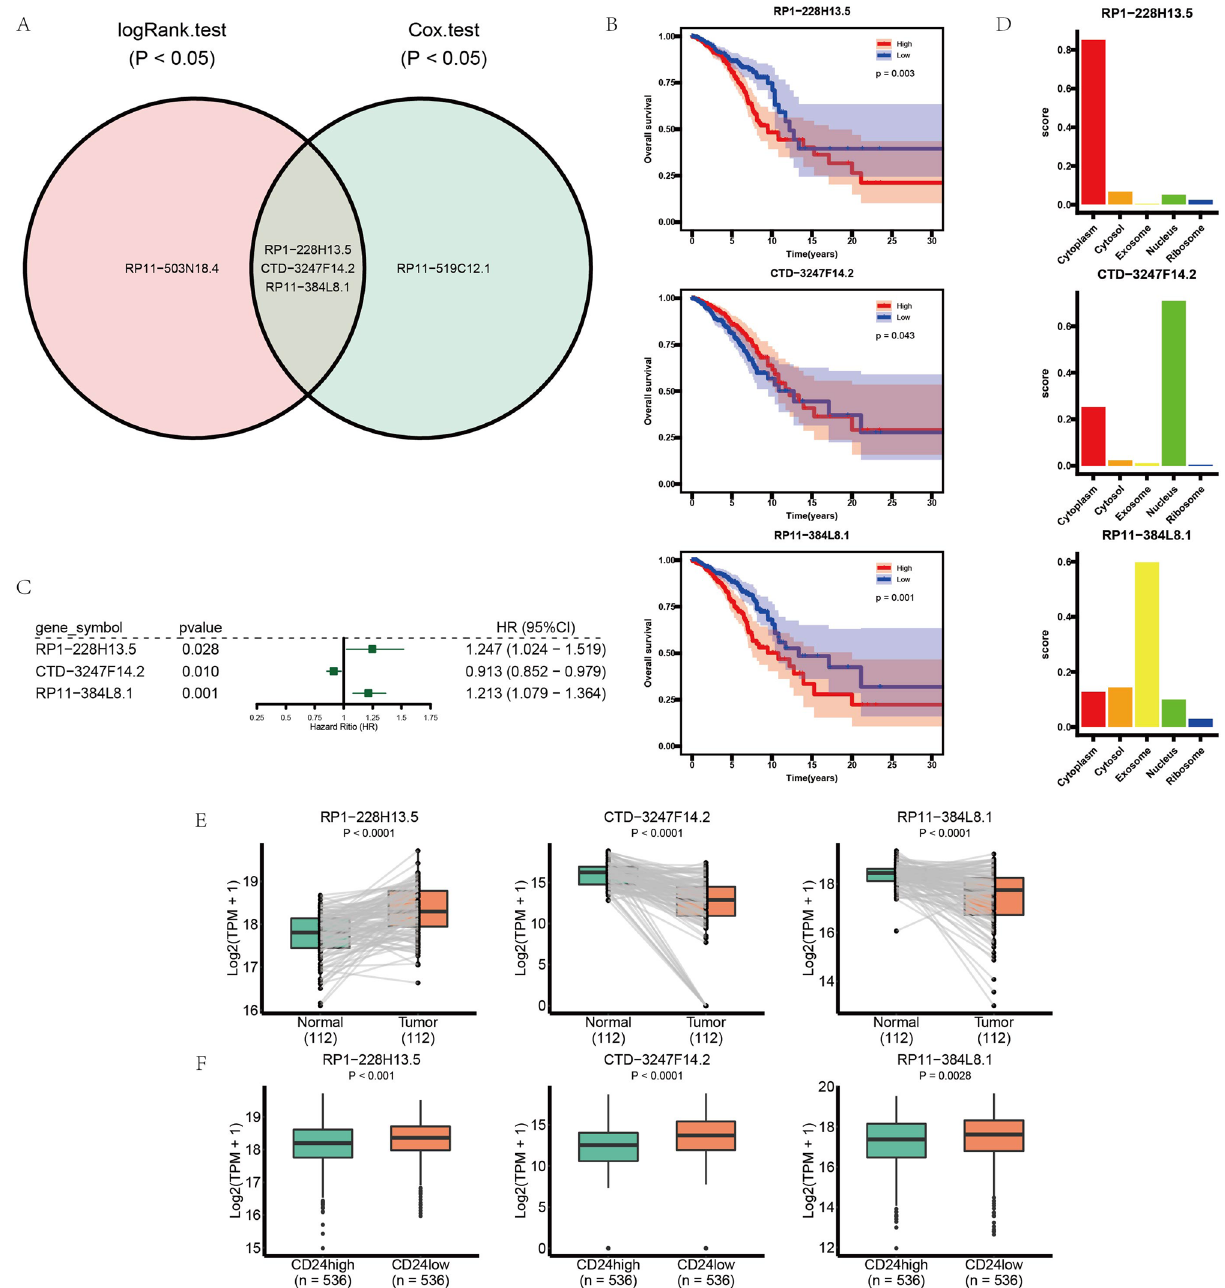
Figure 6. Comprehensive analysis of DElncRNAs. ( A ) Veen diagram of prognosis-related DElncRNAs in CD24-based ceRNA network. ( B ) Kaplan-Meier curve analysis of key DElncRNAs. ( C ) Univariate Cox analysis of key DElncRNAs. ( D ) Predicted results of subcellular localization of DElncRNAs through lncLocator web tool. ( E ) The expression levels of key DElncRNAs in tumor samples and paired adjacent normal samples. ( F ) The expression levels of key DElncRNAs in two groups: CD24high samples and CD24low